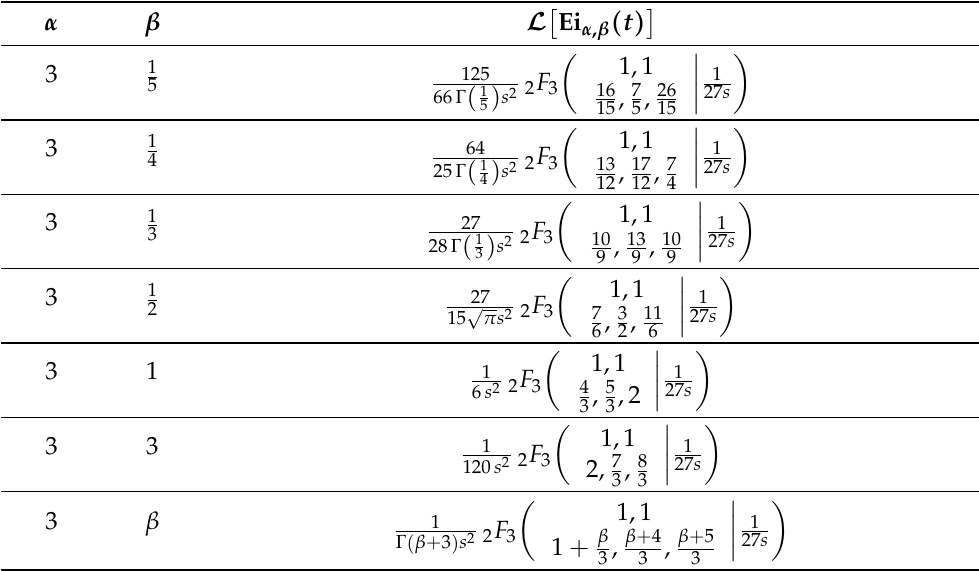
Table 4. The Laplace transforms of the integral Mittag-Leffler functions Ei α , β derived for some values of parameters α and β by using